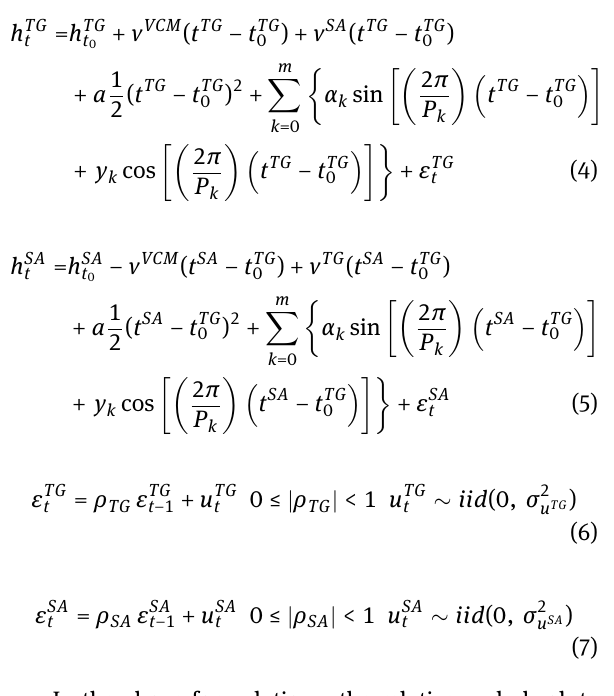
of TG trend and VCM trend in SA